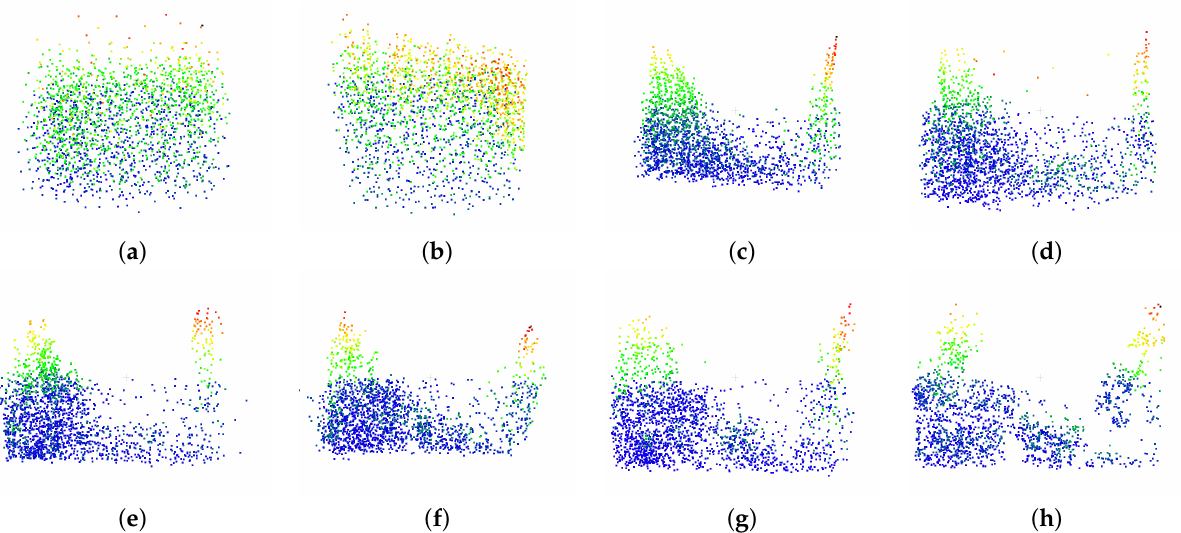
Figure 11. Progression of the reconstruction operation on the DALES Viewpoints Version 2 dataset. All point clouds are colored by height. The network begins to identify the occlusion areas in the initial epochs and then refines the details in later epochs: ( a ) 10 epochs, ( b ) 50 epochs, ( c ) 100